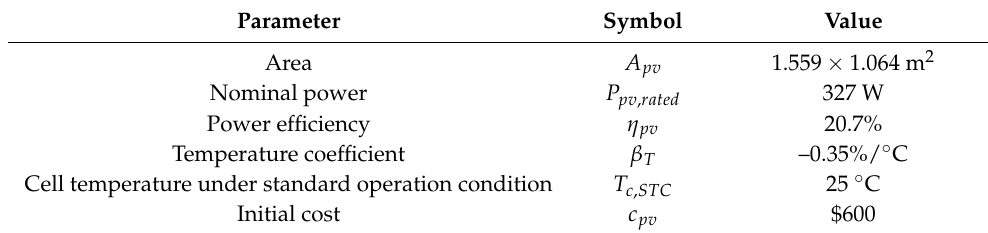
Table 3. Parameters of PV Panels.